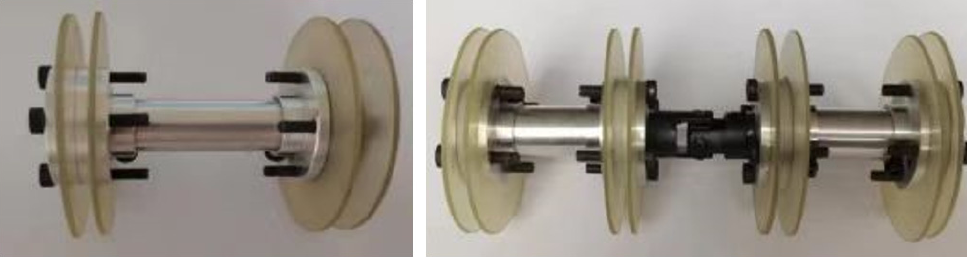
Figure 23. Pipe robot model.